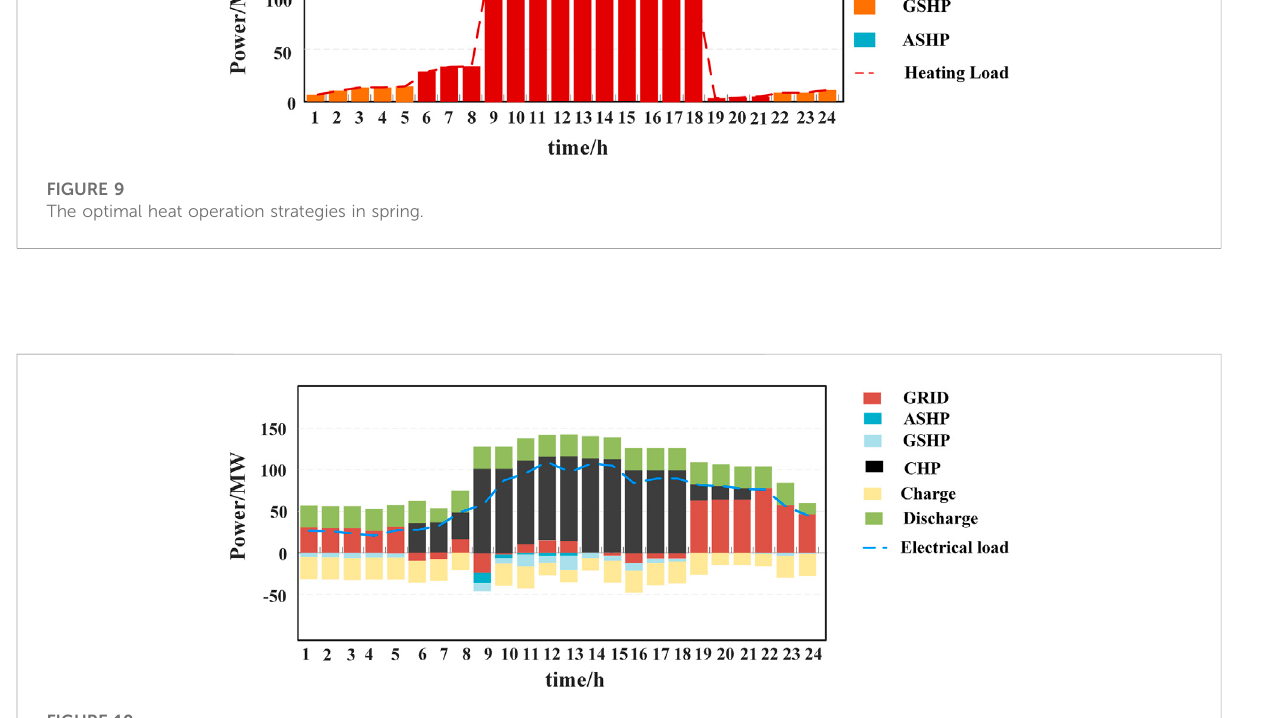
FIGURE 10 The optimal electricity operation strategies in